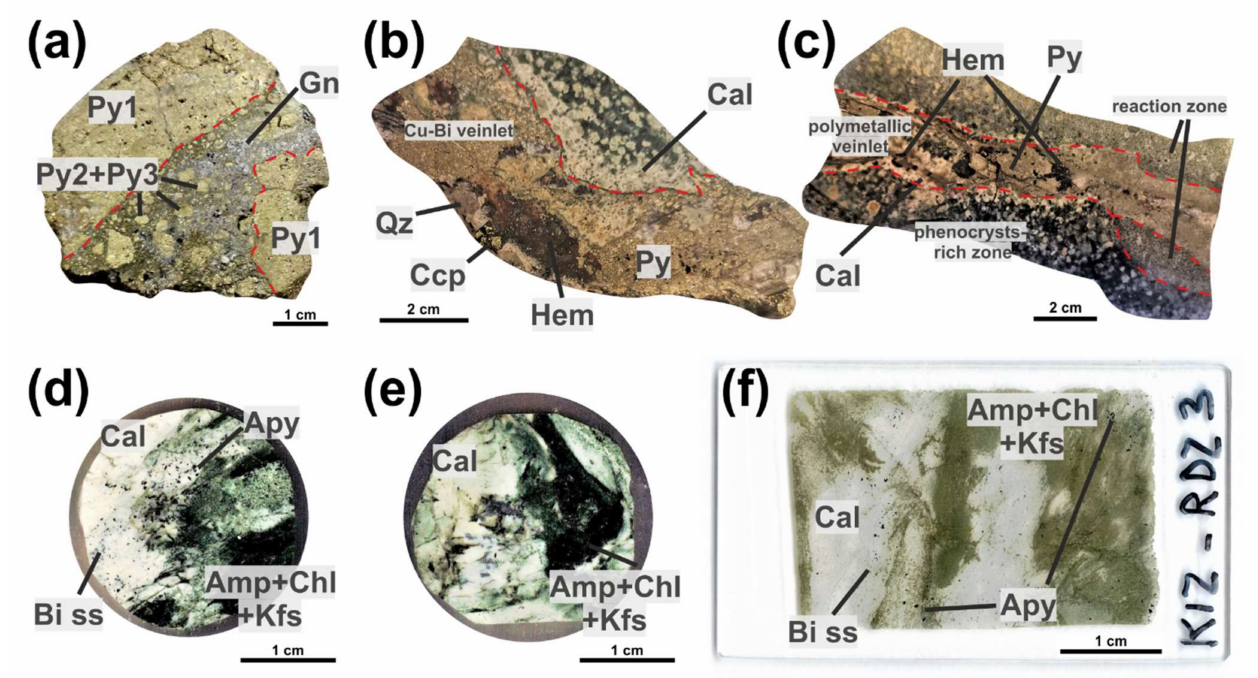
Figure 3. Types of Cu-Bi-Au mineralization from the Kizhnica andesite quarry ( a – c ) and Kizhnica hornfels ( d – f ): ( a ) pyrite- galena-quartz breccia with 3 types of pyrite and galena; ( b ) Cu-Bi veinlet with pyrite, hematite, chalcopyrite, quartz, and calcite; ( c ) Cu-Bi veinlet with pyrite, hematite, and calcite; phenocrysts-rich zone and reaction zone in andesite; ( d ) hornfels composed of amphiboles, chlorites, K-feldspar with mineralized calcite with idiomorphic arsenopyrite crystals, and bismuth sulfosalts; ( e ) hornfels composed of amphiboles, chlorites, K-feldspar with calcite; ( f ) hornfels composed of amphiboles, chlorites, and K-feldspar with mineralized calcite. Abbreviations: Apy = arsenopyrite; Amp = amphiboles; Bi ss = bismuth sulfosalts; Cal = calcite; Ccp = chalcopyrite; Chl = chlorites; Gn = galena; Hem = hematite; Kfs = K-feldspar; Qz = quartz; Py =